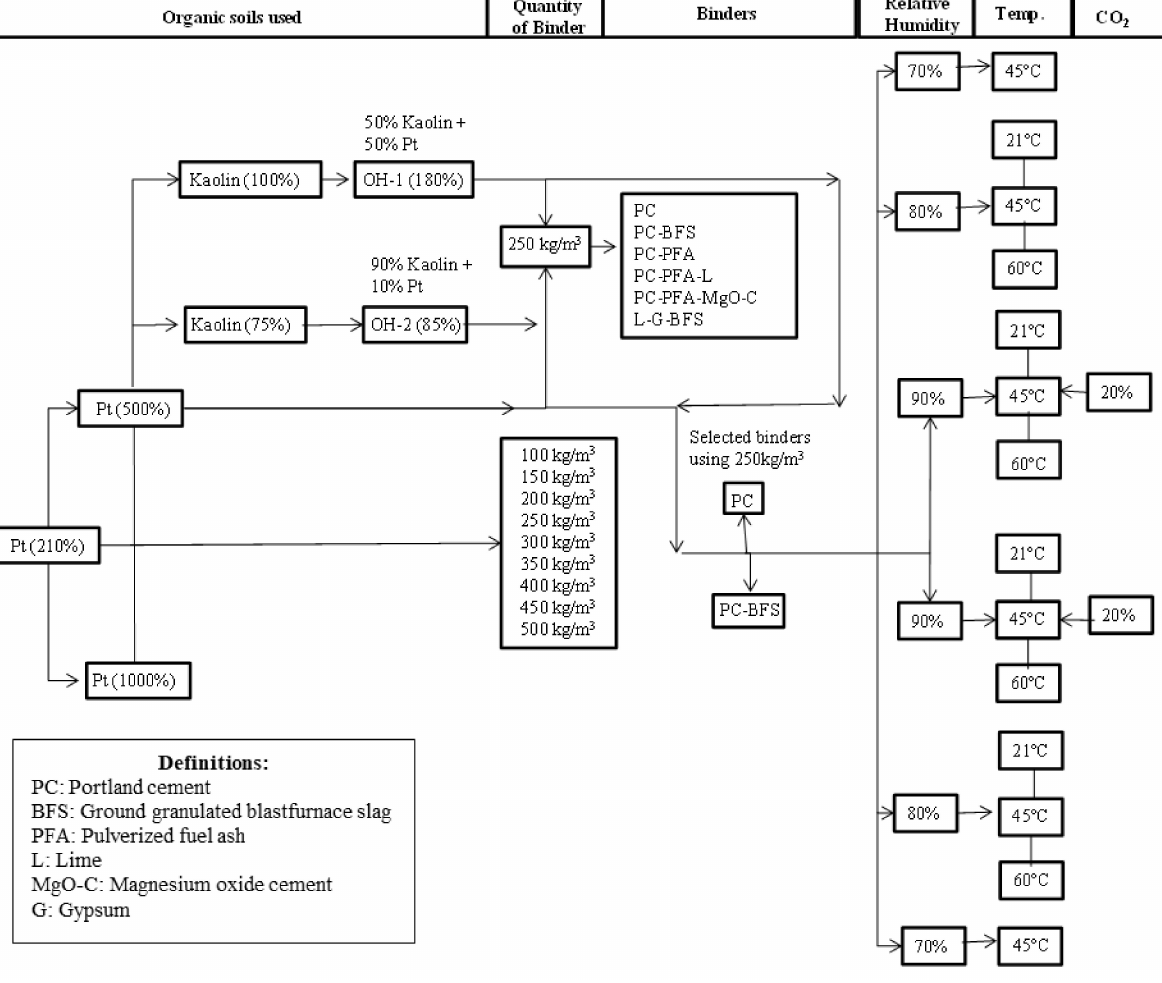
Figure 1. Flow diagram of the experimental